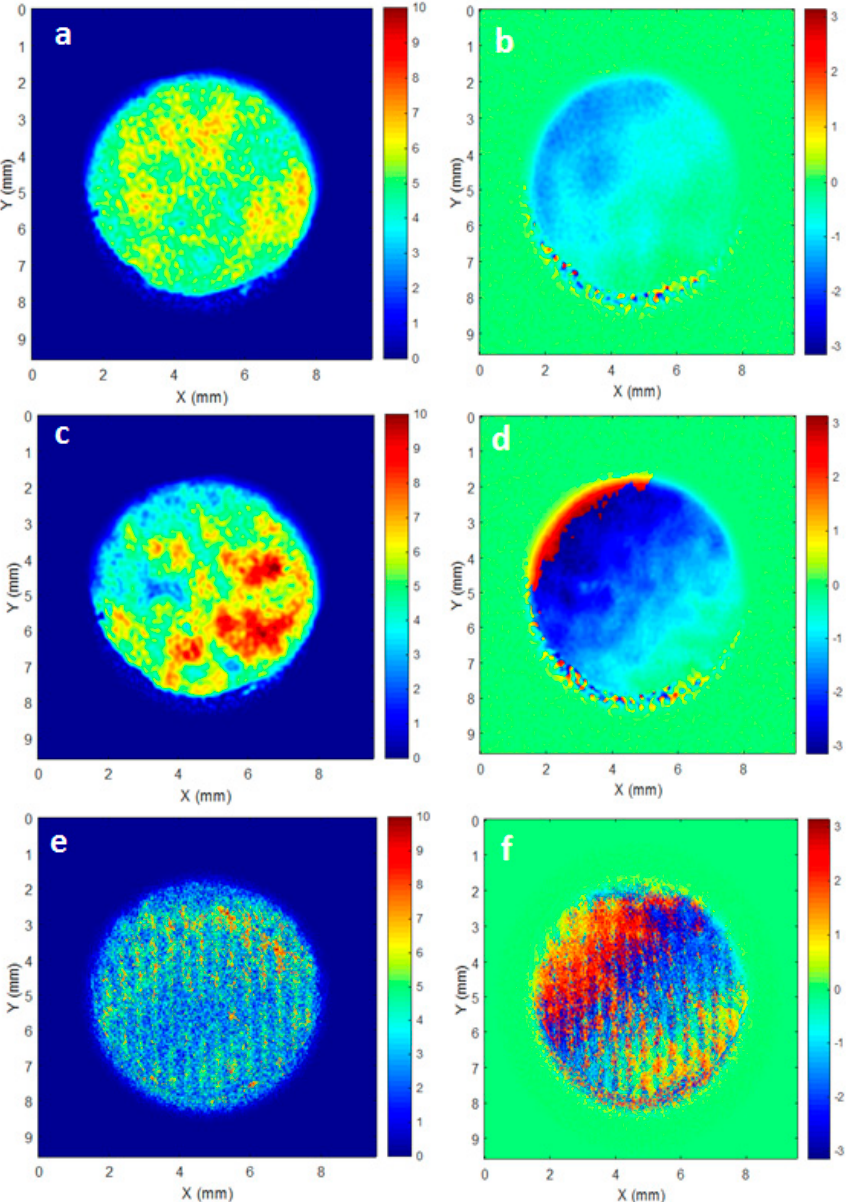
Figure 5. THz-TDS-based CCD imaging results at 200 GHz: ( a , b ) printed silver on a Teslin paper substrate without rolling treatment; ( c,d ): printed silver on a Teslin paper substrate with rolling treatment; ( e,f ) printed silver ink electrodes on a thin polyethylene film substrate. The left plots are the absorption rate (cm − 1 ) and the right plots are the phase angle ( 𝜋,−𝜋) .